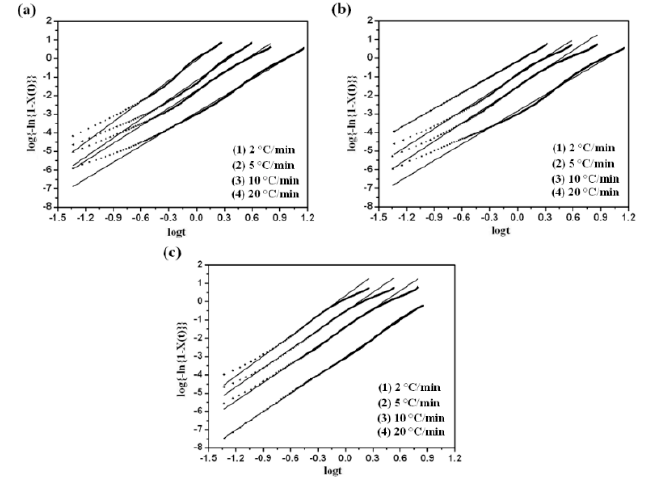
(cid:8) − (cid:8) (cid:9)(cid:9) ln 1 − X ( t ) versus log t for ( a ) PVDF / DMP, ( b ) PVDF / DEP